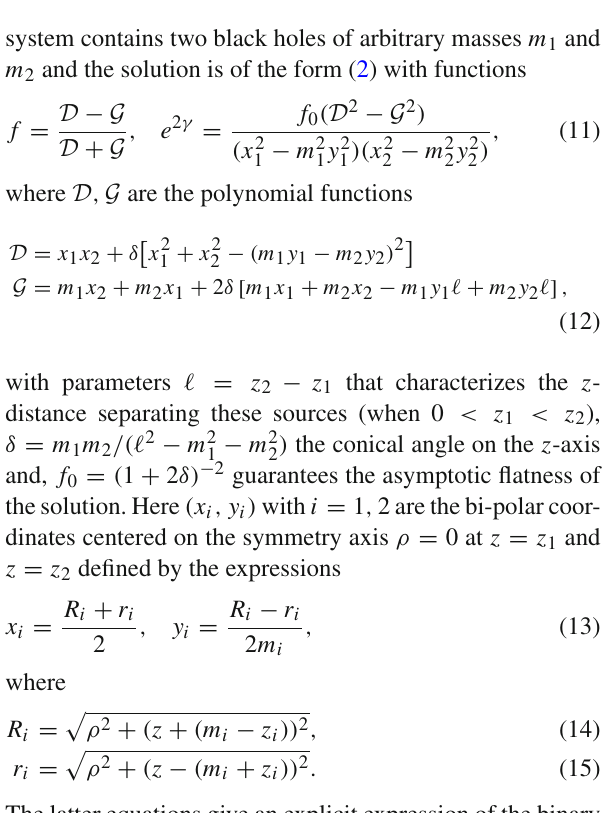
Fig. 1 Electromagnetic structure of a radial magnetic monopole field (in orange) in a Schwarzschild black hole represented in cartesian (left) and Weyl (right)